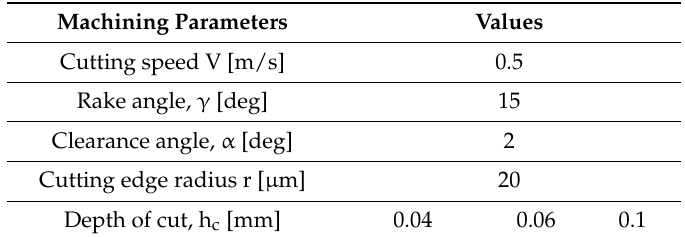
Table 3. Experimental conditions described in (data from